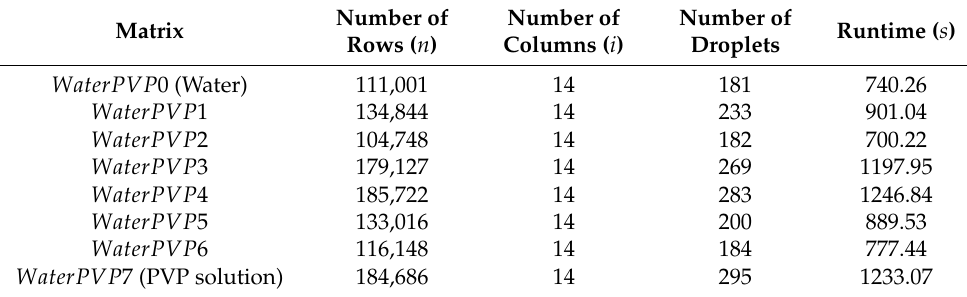
Table 3. The data after